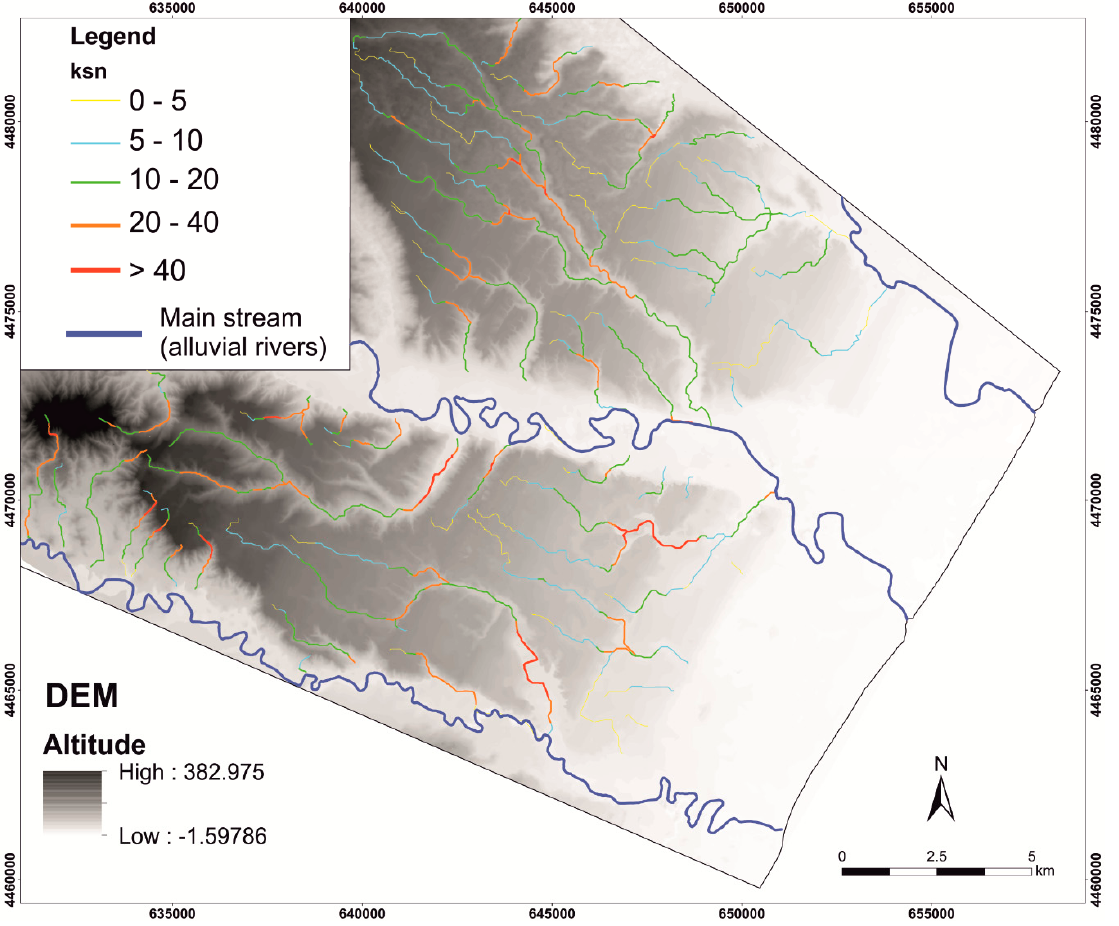
Figure 9. Ksn map of the study area.